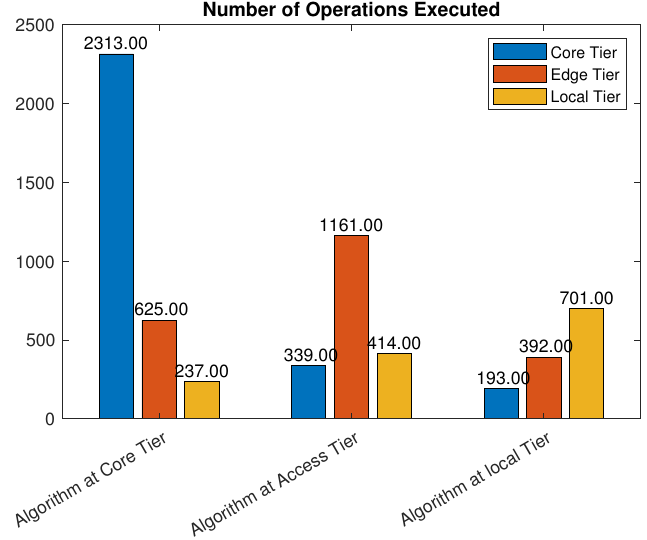
Figure 13. Number of operations executed: with the